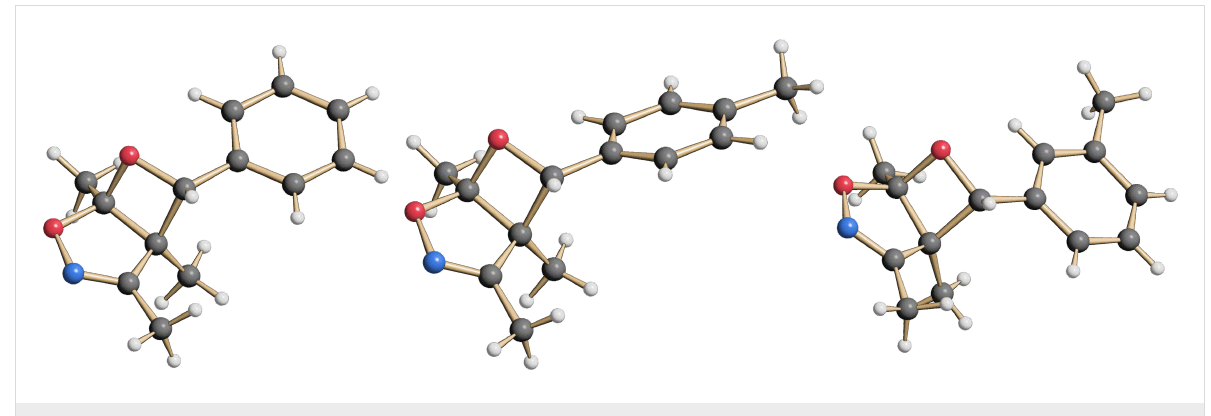
Figure 1: Structures of the photoproducts 9a – 9c in the crystal.